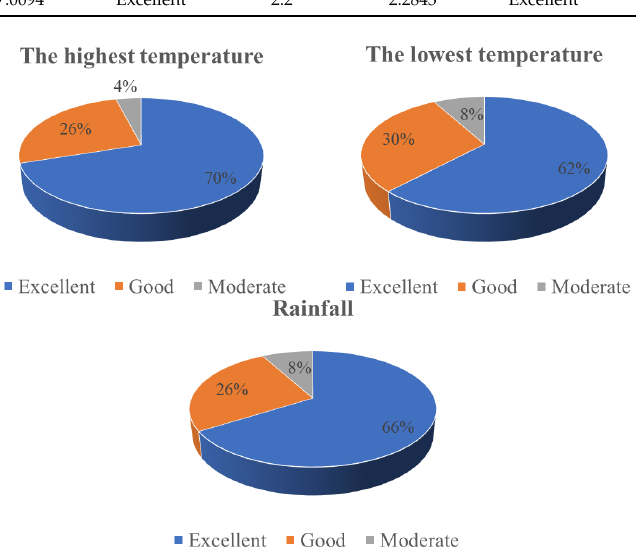
Figure 22. The proportion of each quality in the predicting climate data.